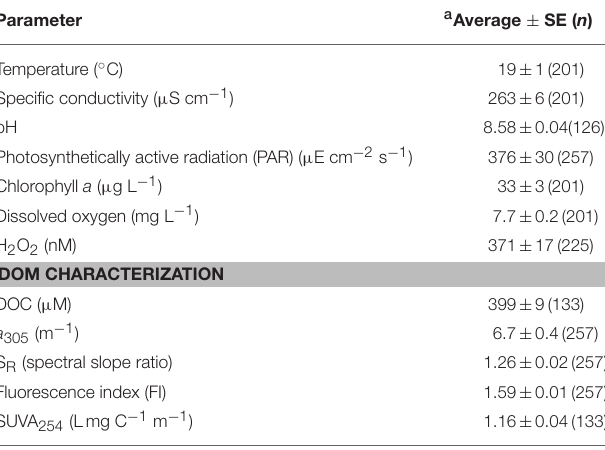
TABLE 1 | Physical, chemical, biological water quality of the western basin in Lake